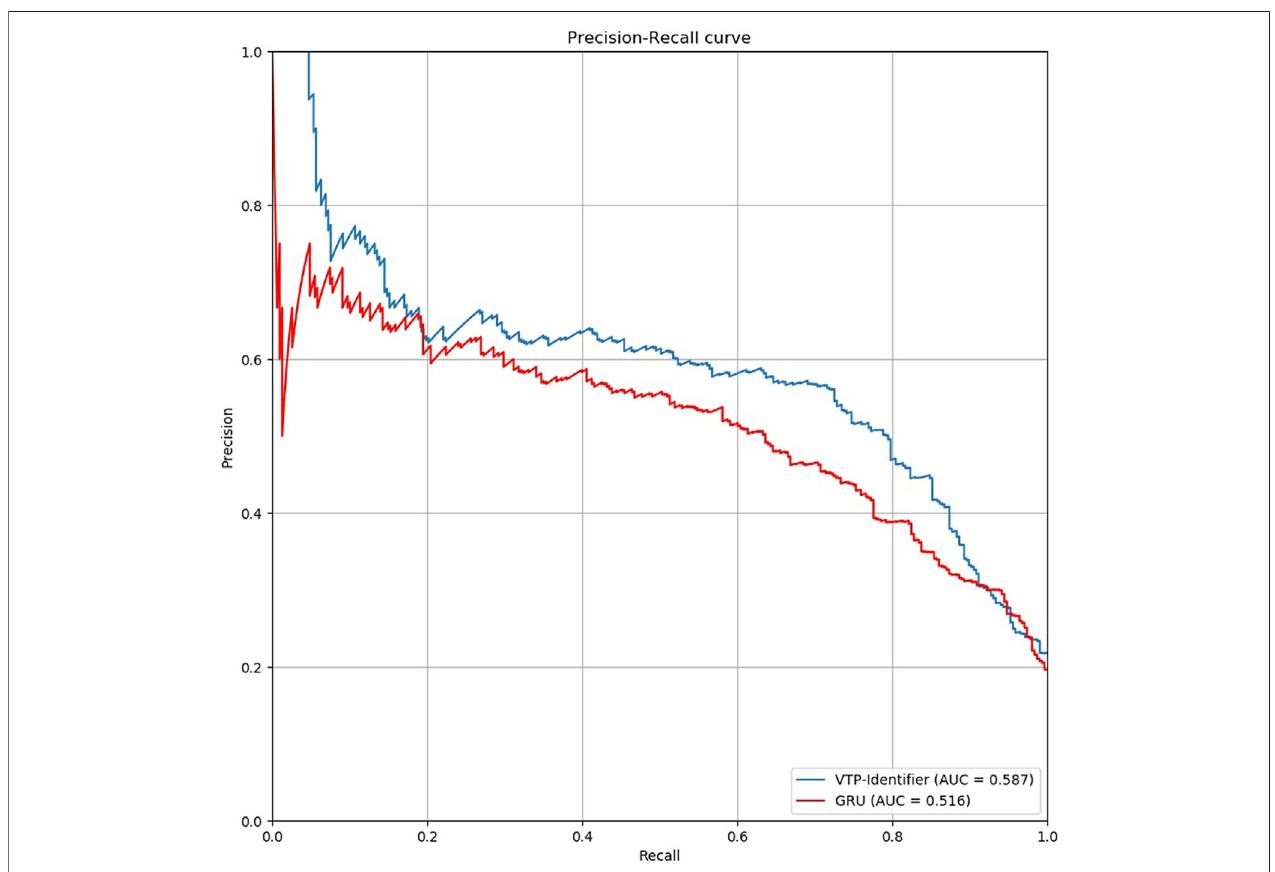
FIGURE 5 | Comparison of PR curves between our model and